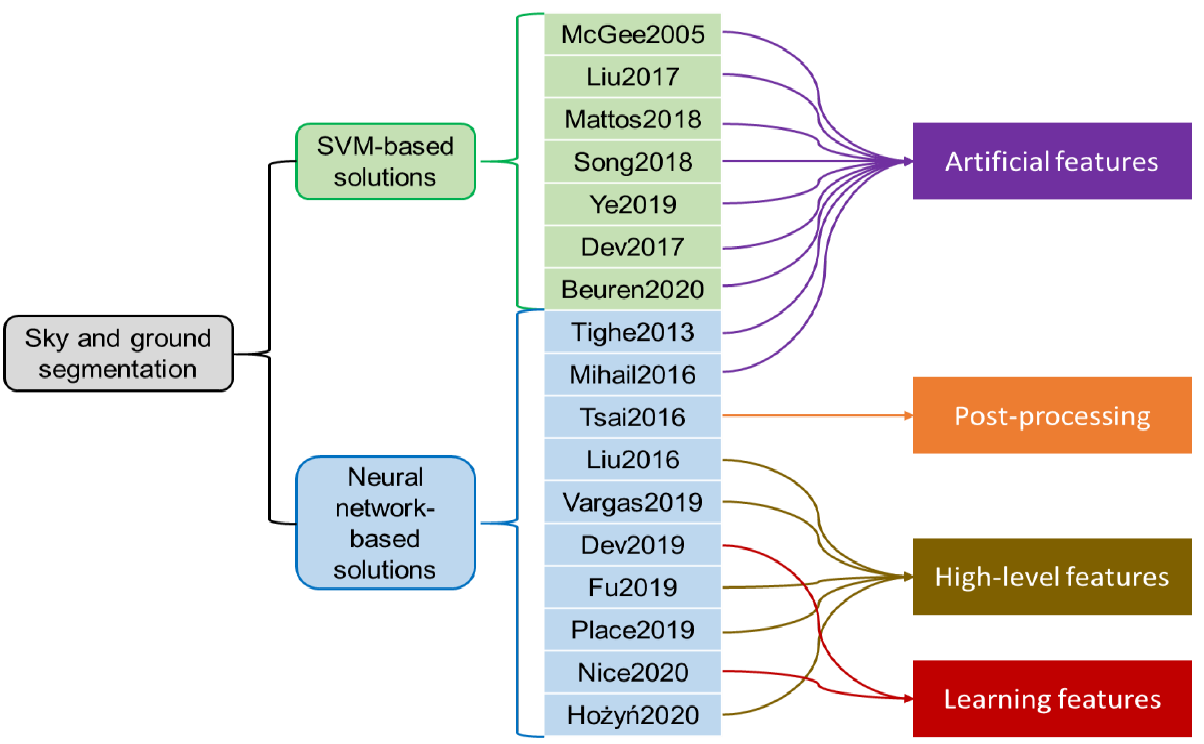
Figure 1. The group of the related works. McGee2005, Liu2017, Mattos2018, Song2018, Ye2019, Dev2017, Beuren2020, Tighe2013, Mihail2016, Tsai2016, Liu2016, Vargas2019, Dev2019, Fu2019, Place2019, Nice2020, and Hożyń2020 refer to [2,10,12,23–28,31–36,39], respectively.